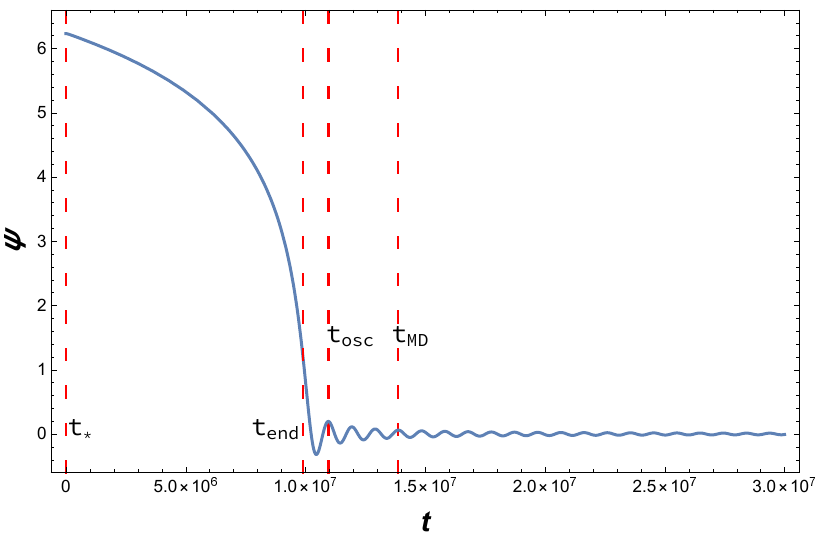
= 1 . Note that t = 0 ∗ 4 end 1 . 096 × 10 7 marks the point at which osc ’ m 2 ψ 2 and t MD ’ 1 . 387 × 10 7 indicates the 2